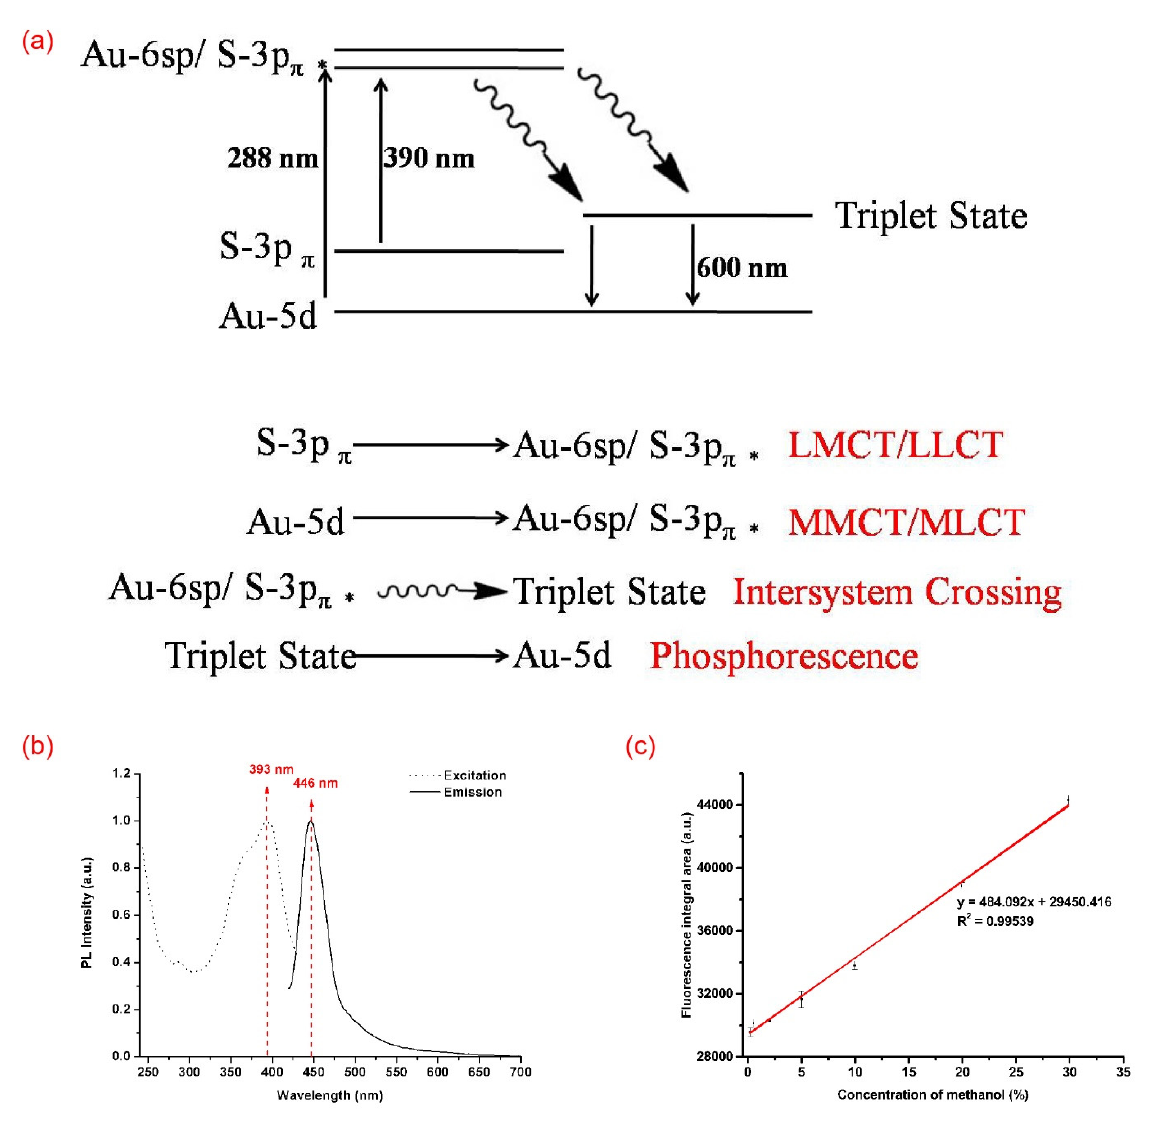
Figure 4. ( a ) Proposed emission mechanism of AuNC@MUA; ( b ) excitation and emission of AuNC@MHA; ( c ) linear correlation between the concentration of methanol and the PL integral area. LMCT, ligand-to-metal charge transfer; LLCT, ligand-to-ligand charge transfer; MMCT, metal-to-metal charge transfer; MLCT, metal-to-ligand charge transfer.